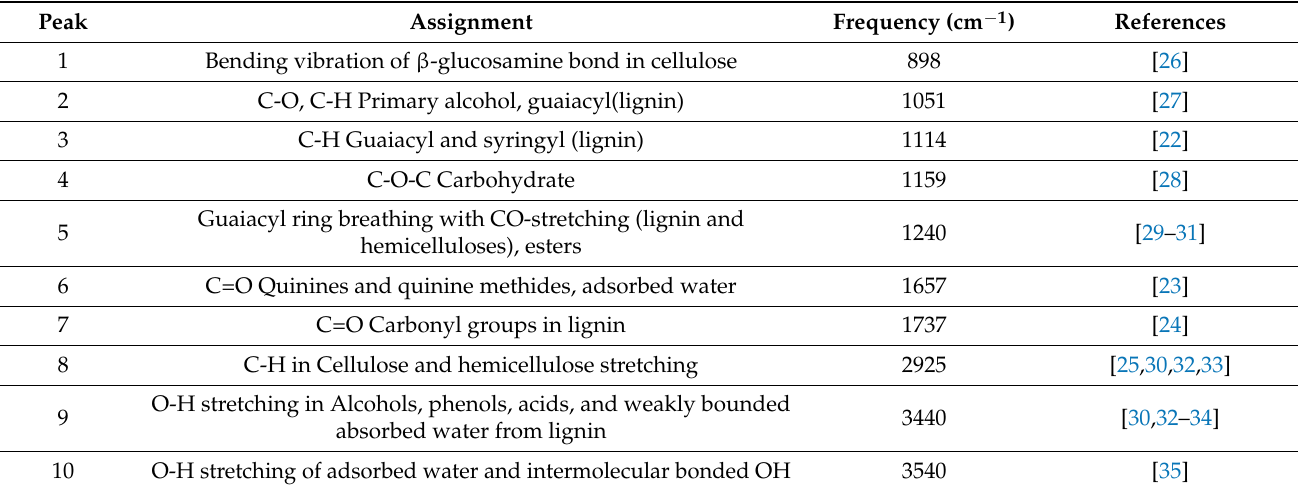
Figure 4. FTIR spectra in the range of 400–1800 cm − 1 and 2800–3800 cm − 1 , obtained from the outermost layers of untreated and modified bamboo specimens. Table 2. Characteristic bands of FTIR spectra in the frequency interval of 400 to 1800 cm − 1 and 2800 to 3800 cm − 1 obtained from the outside and inside surfaces of bamboo